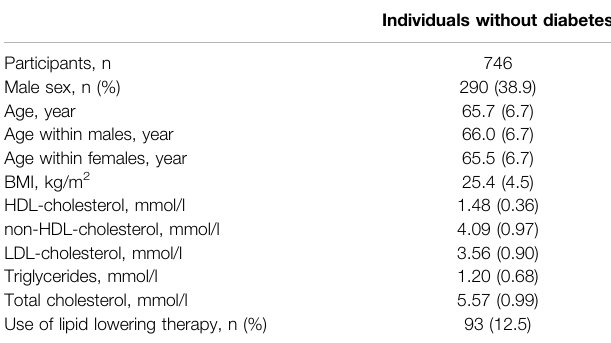
TABLE 2 | DiaGene cohort